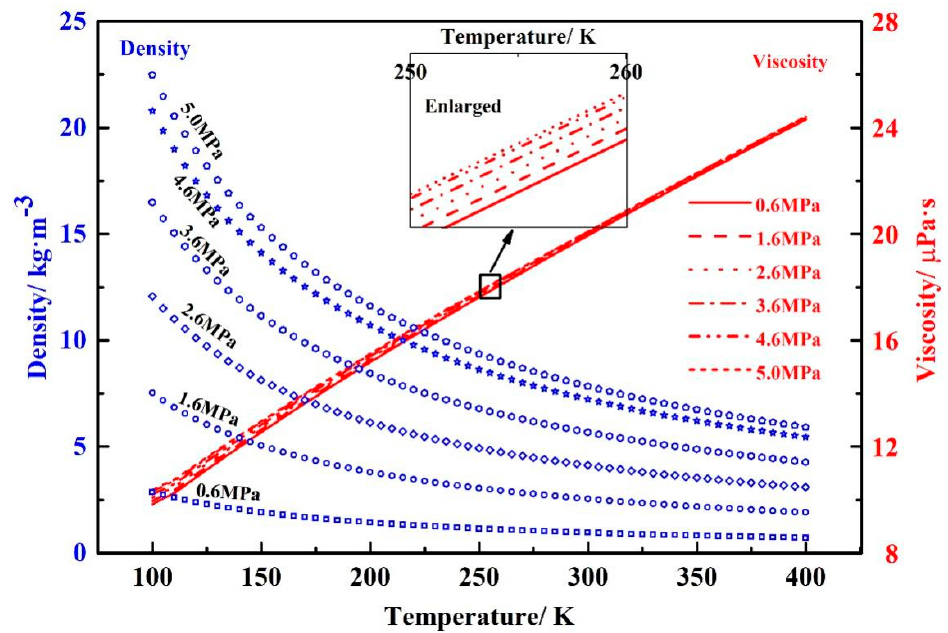
Figure 2. The density and viscosity of helium under different operating conditions [44].